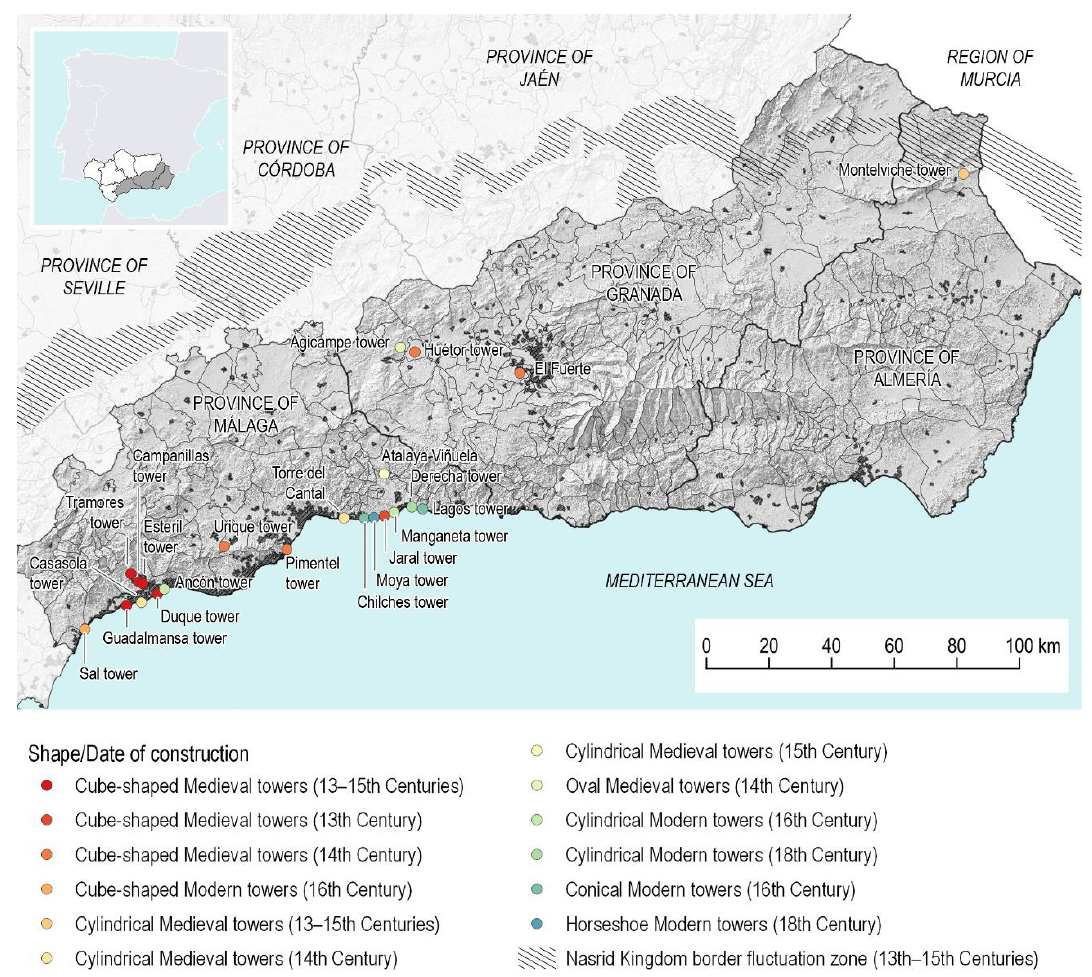
Figure 6. Locations of towers included in this study.